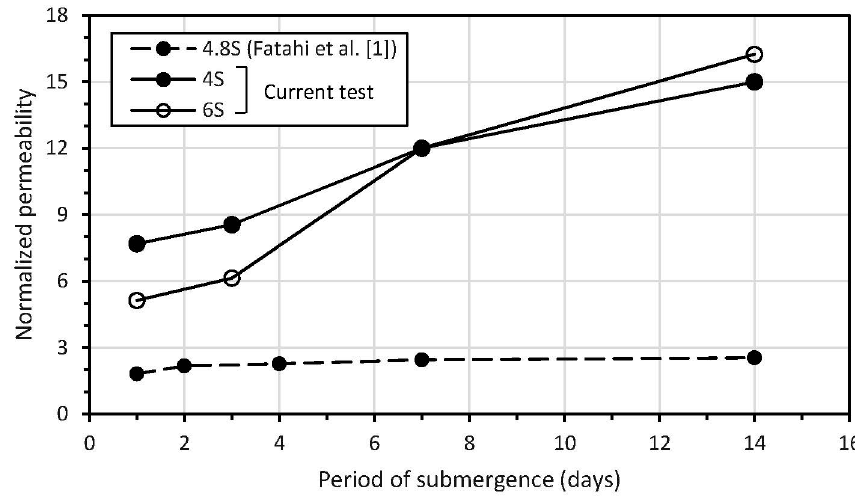
Figure 15. Comparison with existing literature.